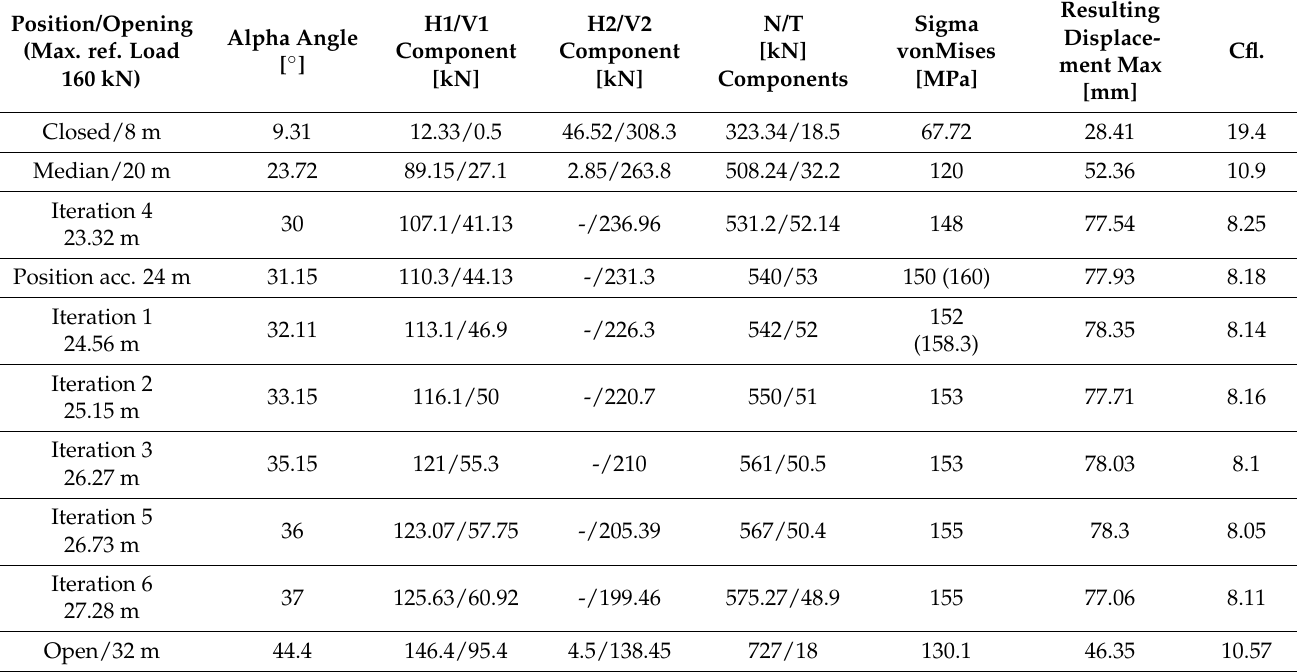
Table 1. Stress and deformation fields at the level of different structural elements.